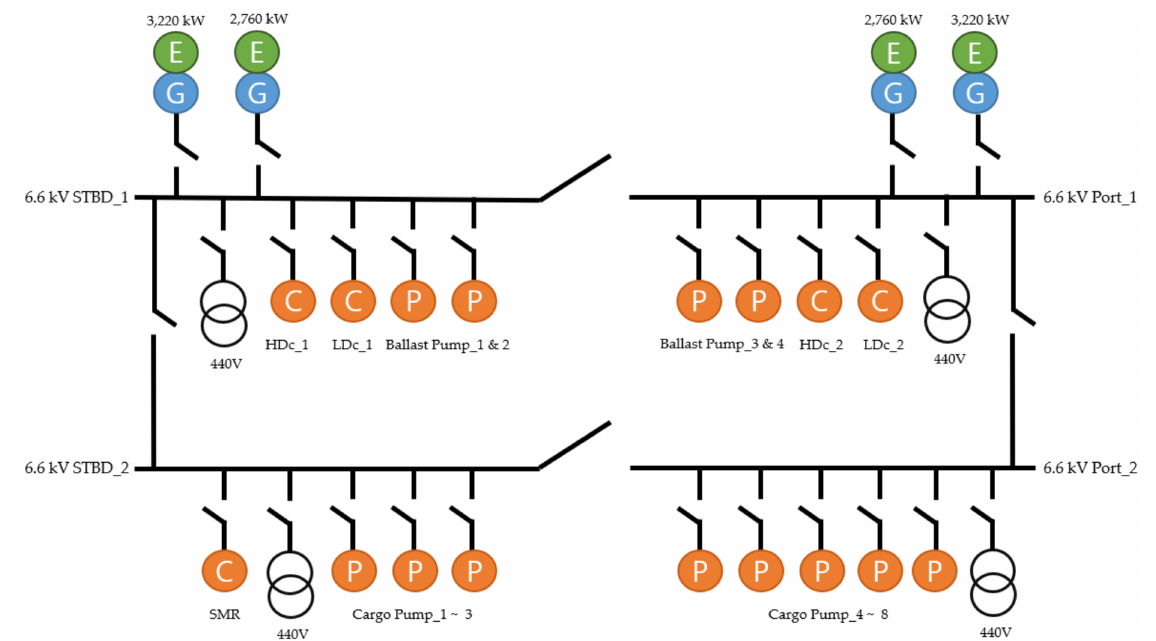
Figure 1. Example of a typical power system of a liquefied natural gas (LNG)